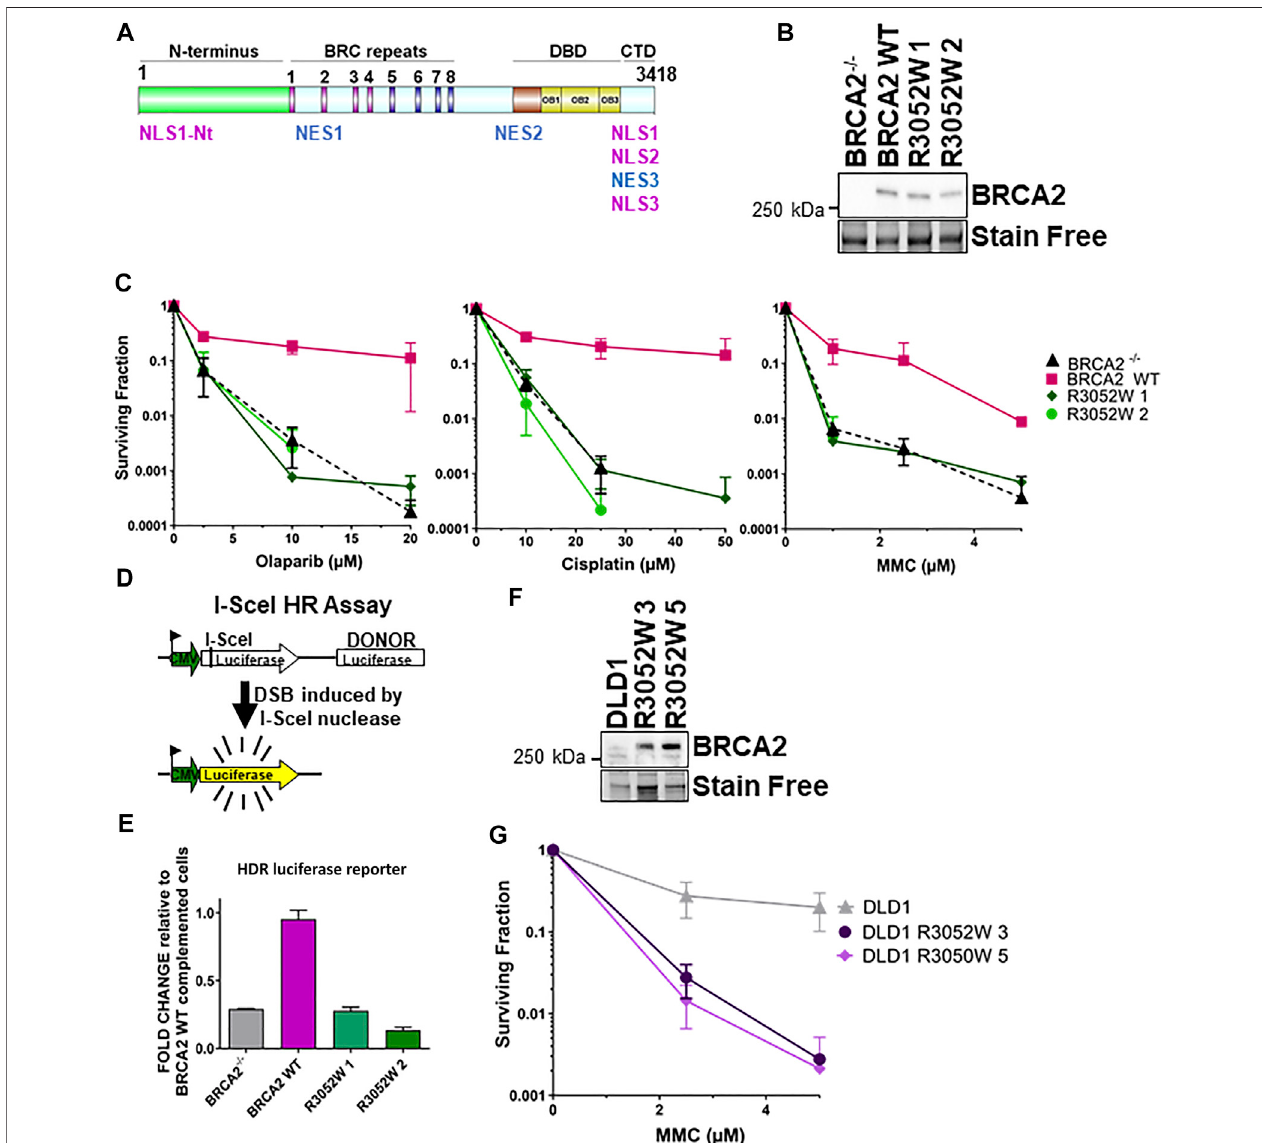
FIGURE 1 | The BRCA2 R3052W mutation fails to complement chemotherapeutic sensitivity and homology-directed repair functions in BRCA2 knockout cells. Overexpression of R3052W in DLD1 parental BRCA2 wild-type cells confers sensitivity to MMC DNA damage. (A) BRCA2 protein schematic depicting domain organization:N-terminus,BRCrepeatsDNAbindingdomain(DBD),andC-terminaldomain(CTD).BRCA2nuclearlocalizationandexportsequencesarelisted.NLS1-Nt (433 – 436 aa), NLS1 (3,265 – 3,270 aa) NLS2 (3,311 – 3,317 aa), NLS3 (3,381 – 3,385 aa), NES1 (1,383 – 1,392 aa), NES2 (2,682 – 2,698 aa) and NES3 (3,270 – 3,280 aa). (B) Western blot of total cellular lysates from DLD-1 BRCA2 − / − cells stably transfected with full-length BRCA2 cDNA constructs: BRCA2 Wild Type (WT) and BRCA2 R3052W (1 and 2 correspond to two independent clones). BRCA2 cDNAs contain a 2XMBP tag on the N-terminus and were detected with an MBP antibody.2XMBP-BRCA2(470 kDa).StainFreeisaprotein-loadingcontrol. (C) ClonogenicsurvivalanalysesofBRCA2WTversusthetwoindependentR3052Wclones after treatment with Olaparib, cisplatin, and mitomycin C. (D) Schematic of I-SceI nuclease-induced DSB HDR luciferase assay. (E) Quanti fi cation of luciferase activity (normalized to BRCA2 WT as 1). Error bars are SD ( n = 5). (F) Western blot of total cellular lysates from DLD-1 parental cells (these cells express a wild-type allele of BRCA2) stably transfected with R3052W (3 and 5 correspond to two independent clones) full-length 2XMBP-BRCA2 cDNA constructs. BRCA2 was detected with an MBP antibody. (G) Clonogenic survival analyses of DLD parental clones upon treatment with mitomycin C.